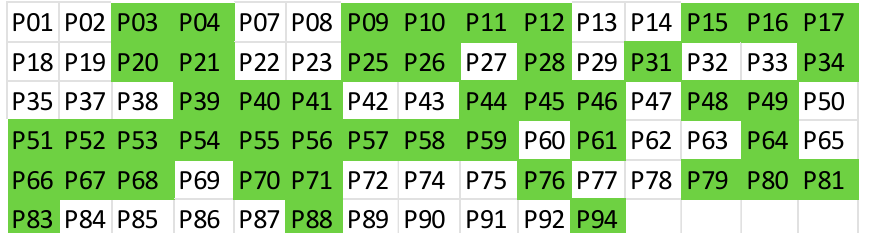
13 of 20 Figure 4. Selected nodes (Green Color) as storm tanks pre-location. The second step of the first part (search space reduction) of the proposed methodology (Figure 1) is the pre-selection of conduits. For this, the pre-locations of storm tanks are used and combined with all the conduits to perform simulations. A reduction in the number of potentially substitutable pipes is sought. The parameters considered in this process are defined by the following. •